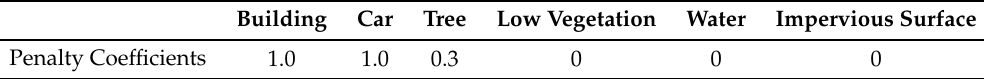
Table 1. The penalty coefficients setting of all object